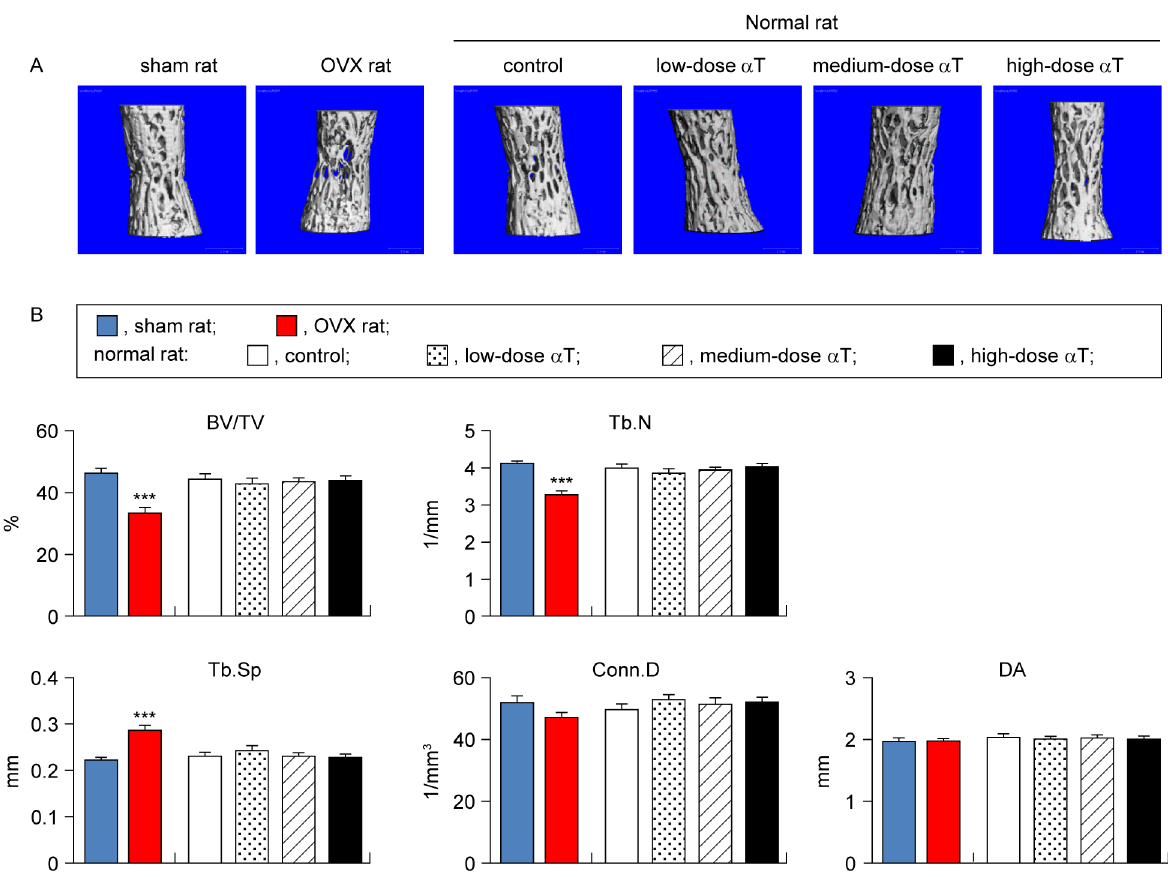
Fig 2. Micro-CT analysis of trabecular bone in vertebral body. (A) Representative 3-dimensional micro-CT images of trabecular bones in vertebral bodies are shown. (B) Microstructural parameters (BV/TV, trabecular bone volume fraction; Tb.N, trabecular number; Tb.SP, trabecular separation; Conn.D, connectivity density; DA, degree of anisotriphy) of trabecular bones in vertebral bodies are shown. Data are presented as mean ± standard error of the mean. *** P < 0.001 vs. sham rat group.